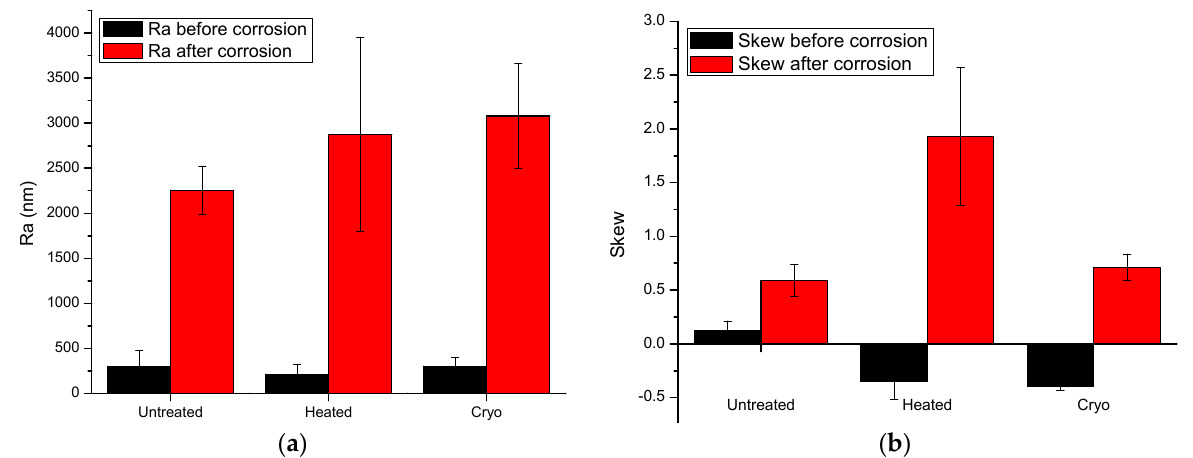
Figure 10. Roughness parameters: ( a ) R a —arithmetic average deviation from the mean line; ( b ) S kew —skewness of the investigated specimens before and after corrosion resistance.